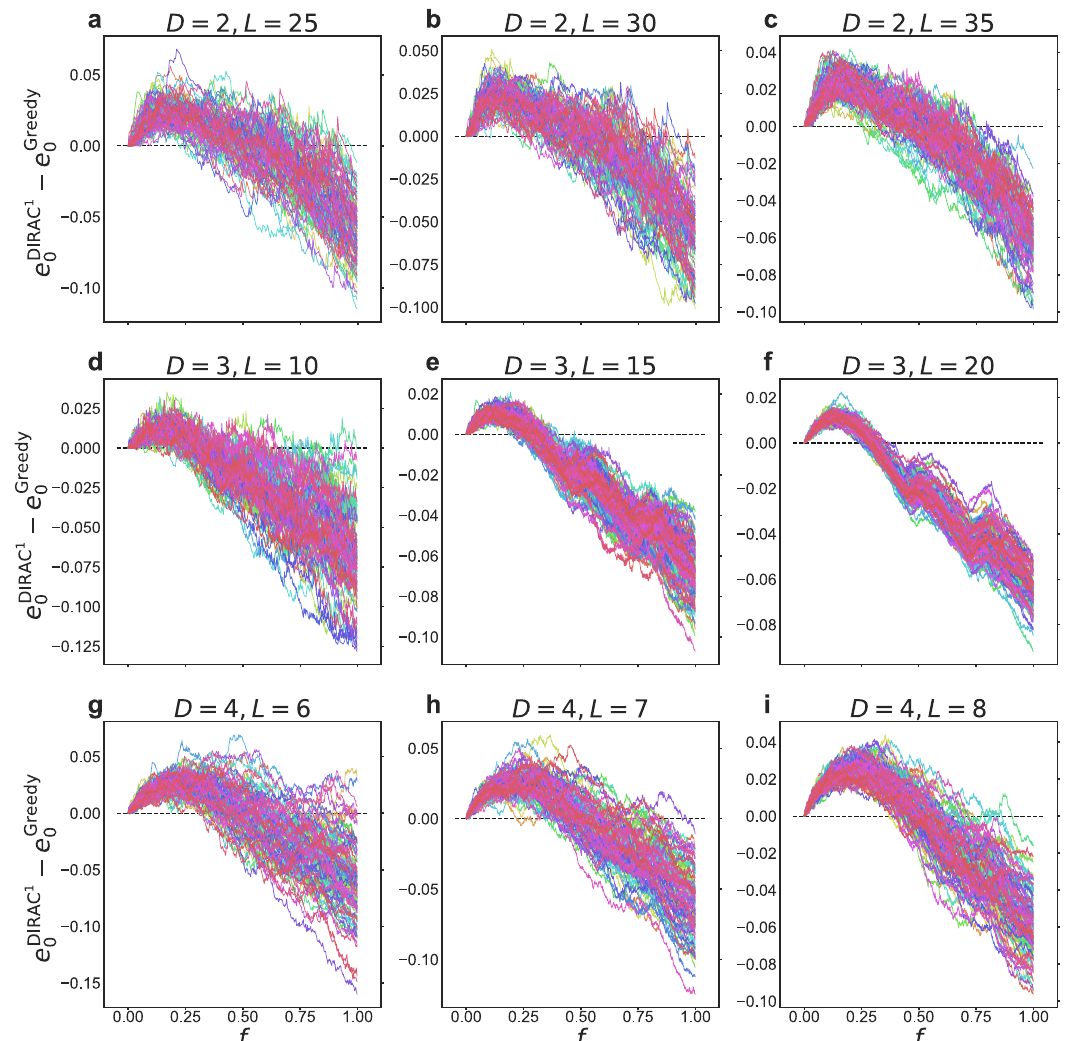
Fig. 6 | A long-sighted greediness. We compared the energy density difference between DIRAC 1 and Greedy ( e DIRAC 0 (cid:1) e Greedy